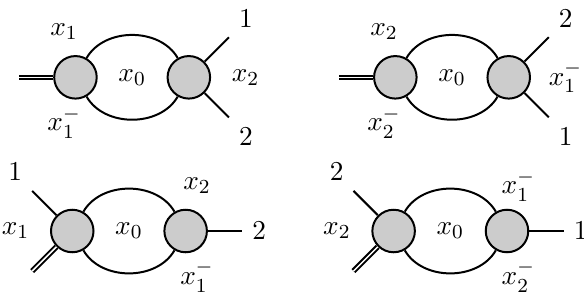
Figure 8. The four one-loop MHV diagrams contributing to the one-loop Sudakov form